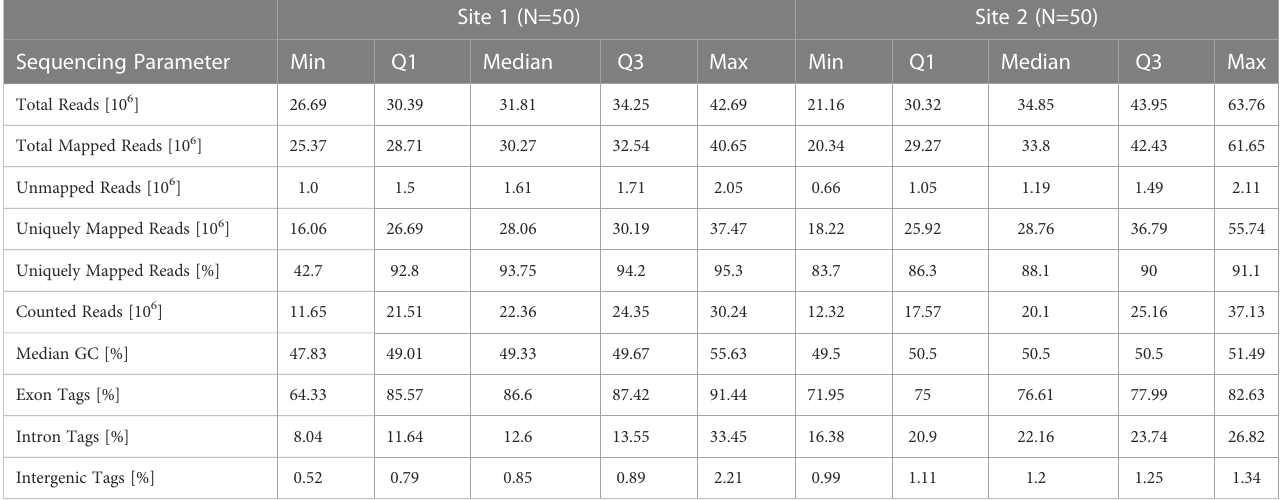
TABLE 1 Summary of human reference alignment